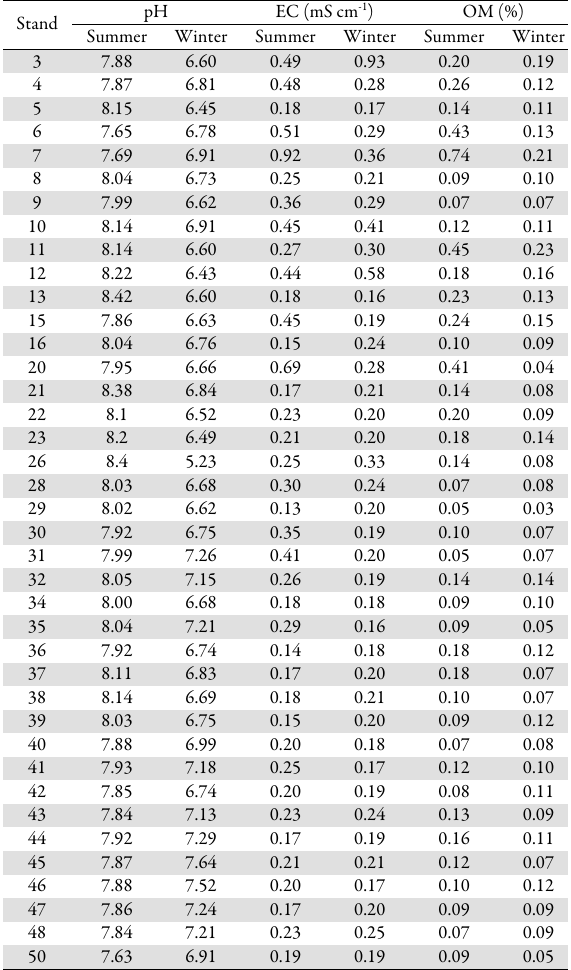
Table 1. pH values, electric conductivity (EC) and organic matter content (OM) at different stands in Wadi El-Assiuty, during summer and winter